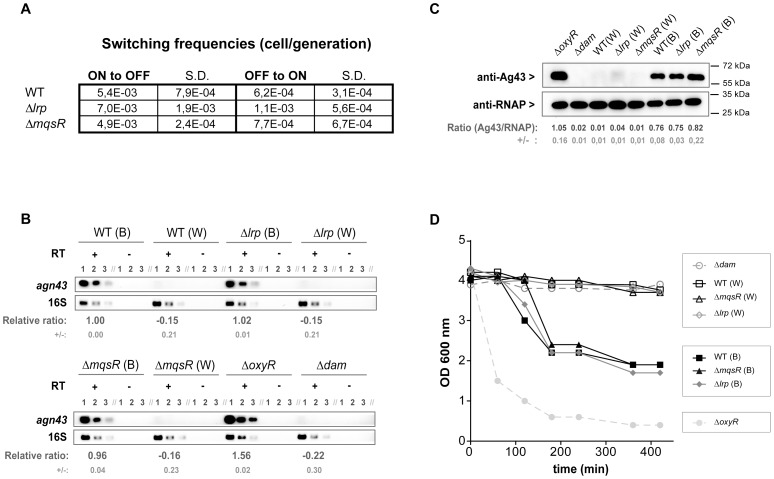
Lrp and MqsR do not regulate agn43 expression.A. Switching frequencies of lrp and mqsR mutants assessed with an agn43-lacZ fusion. S.D.: standard deviation. B. Semi-quantitative RT-PCR analyses of agn43 expression in wild-type (WT), Δlrp, ΔmqsR, ΔoxyR, and Δdam agn43-lacZ strains. Experiments were performed using RNA preparations that were not diluted (1), or diluted 1/10 (2) or 1/100 (3). (B): ON colony, (W): OFF colony, +/− RT: with or without reverse transcriptase polymerase. The 16S (rrsh gene) was used as an internal control. Relative ratio: average of agn43/16S band intensity ratio quantified using ImageJ, WT(B) used as reference; +/−: standard deviation. C. Immunodetection of Ag43 with anti-αAg43 polyclonal antibody in WT, Δlrp and ΔmqsR agn43-lacZ strains. (B): ON colony, (W): OFF colony, the α-subunit of RNA polymerase (RNAP) was used as an internal control. Relative ratios (Ag43/RNAP): band intensity ratio quantified using ImageJ; +/−: standard deviation. D. Kinetics of aggregation of strains TG agn43-lacZ, TG agn43-lacZ Δlrp and TG agn43-lacZ ΔmqsR. (B): ON colony, (W): OFF colony, ΔoxyR: locked-ON strain, Δdam: locked-OFF strain.